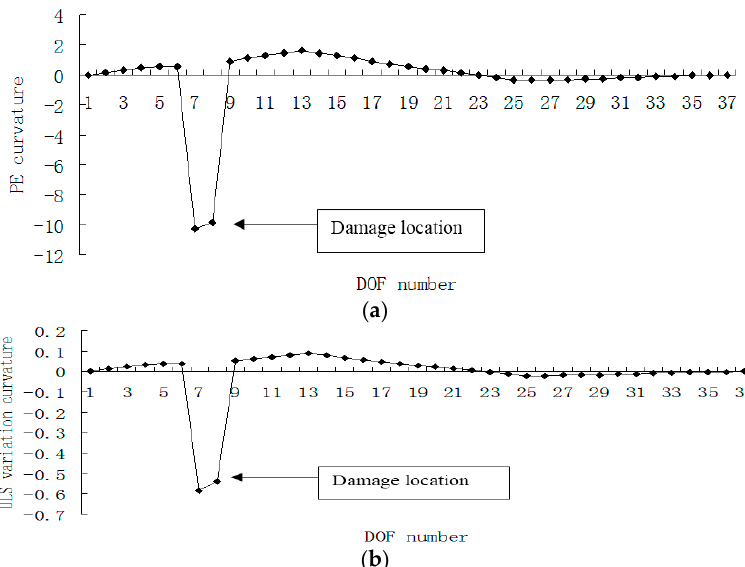
Figure 6. ( a ) Damage index (PE curvature) map using the first four exact modes when the defect occurred in element 7; ( b ) Damage index (ULS variation curvature) map using the first four exact modes when the defect occurred in element 7 (×10 − 3 ).